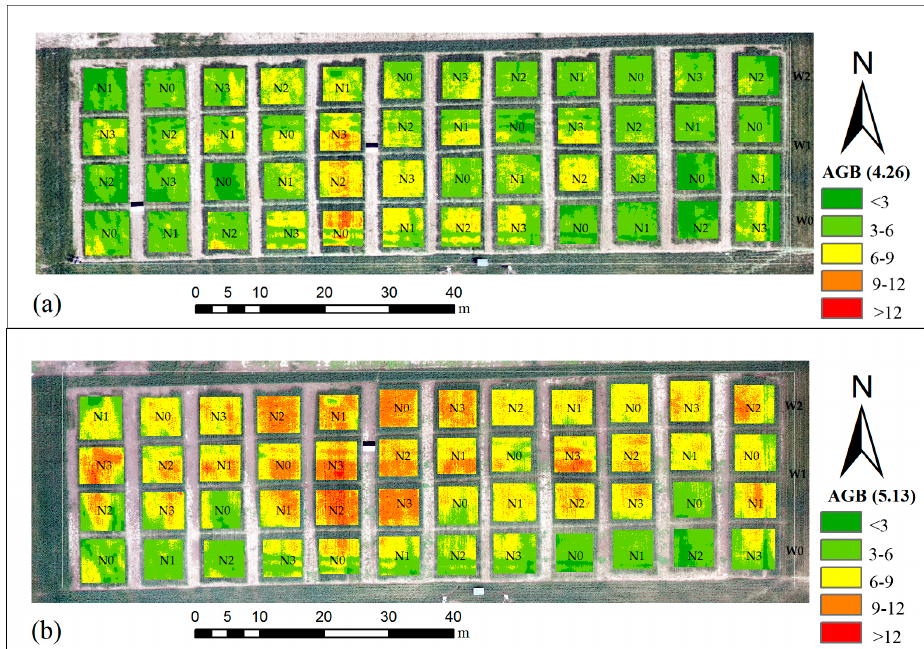
Figure 9. AGB Map: ( a ) AGB during the flagging stage (26 April 2015); ( b ) AGB during the flowering stage (13 May 2015); Dark and light green regions of the image (Figure 9a,b, AGB < 6) correspond to low crop growth, yellow regions (Figure 9a,b, 6 < AGB < 9) correspond to normal crop growth, and orange and red regions (Figure 9a,b, AGB > 9) correspond high crop growth.